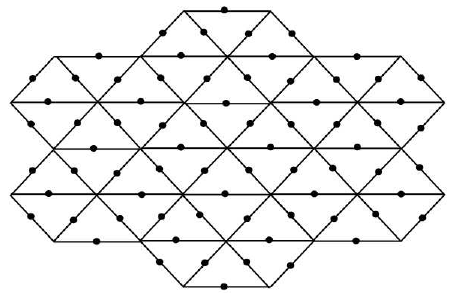
Fig. 9 Subdivision graph of Model of healthy